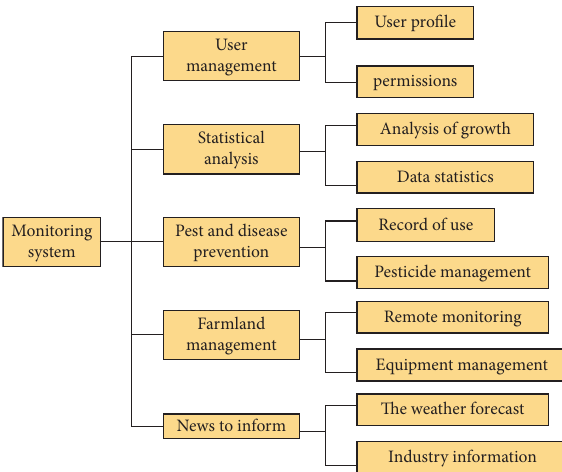
Figure 3: Schematic diagrams of system function modules.